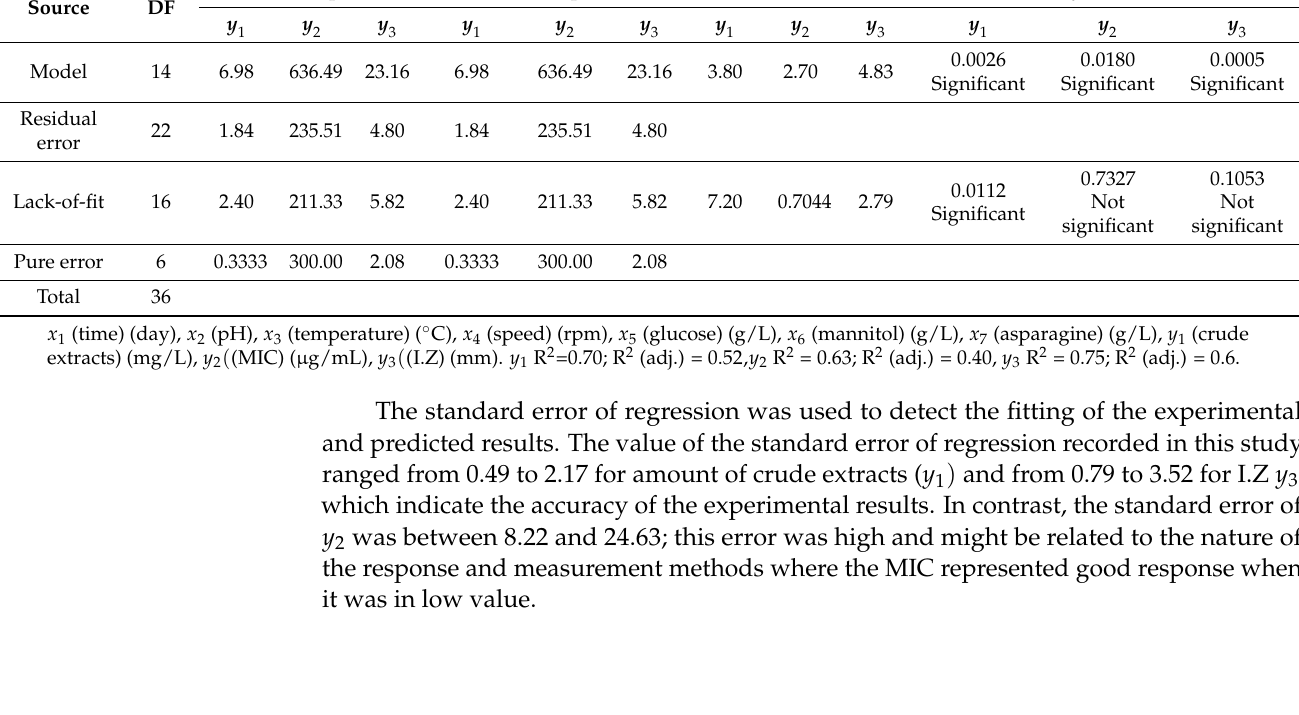
with R 2 = 0.70 of the coefficient for amount of crude extracts y 1 , R 2 = 0.63 for MIC y 2 , and